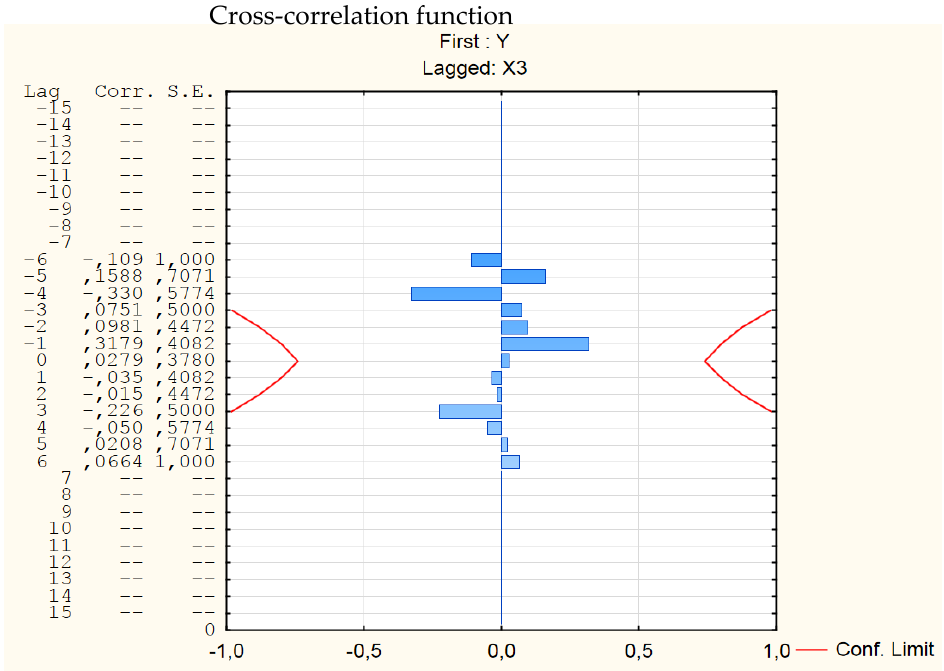
Figure 4. Cross-correlation function for GRP, share of science-intensive products in shipment and productivity index of the Russian Arctic zone (calculated by authors).